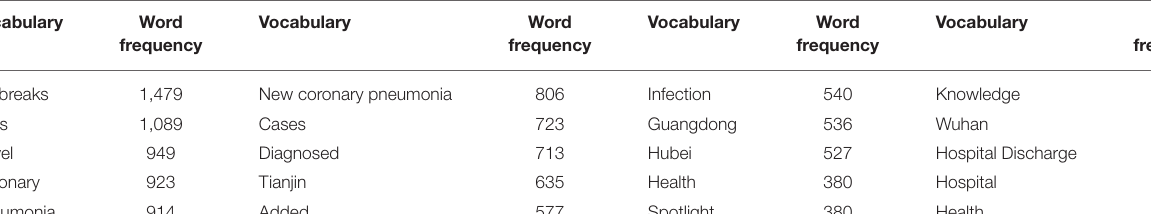
TABLE 7 | Tweets title high-frequency words (partial).